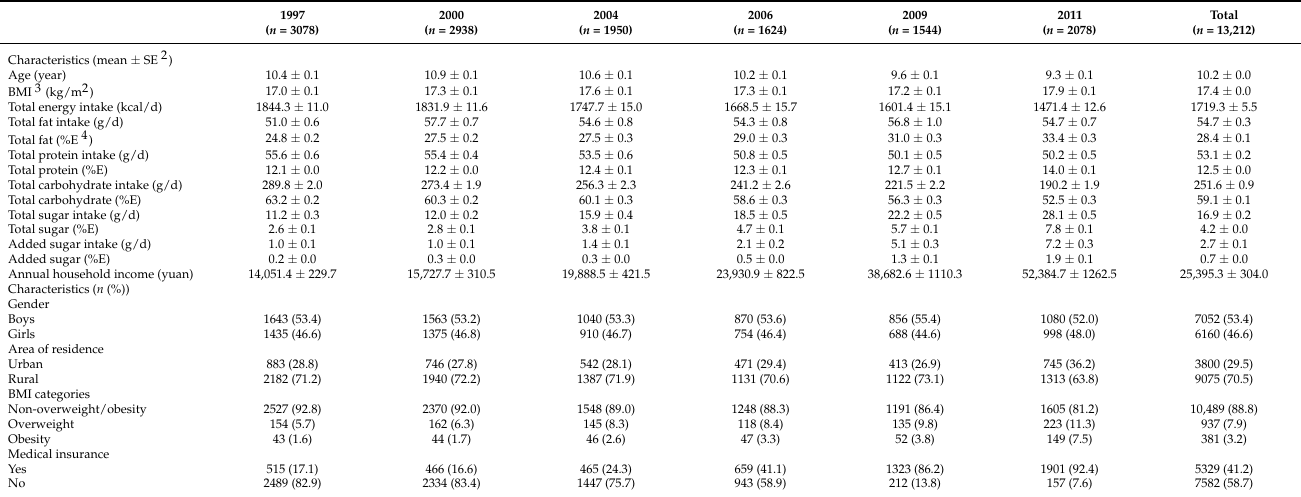
Table 1. Basic demographics and characteristics of Chinese children and adolescents by years, CHNS